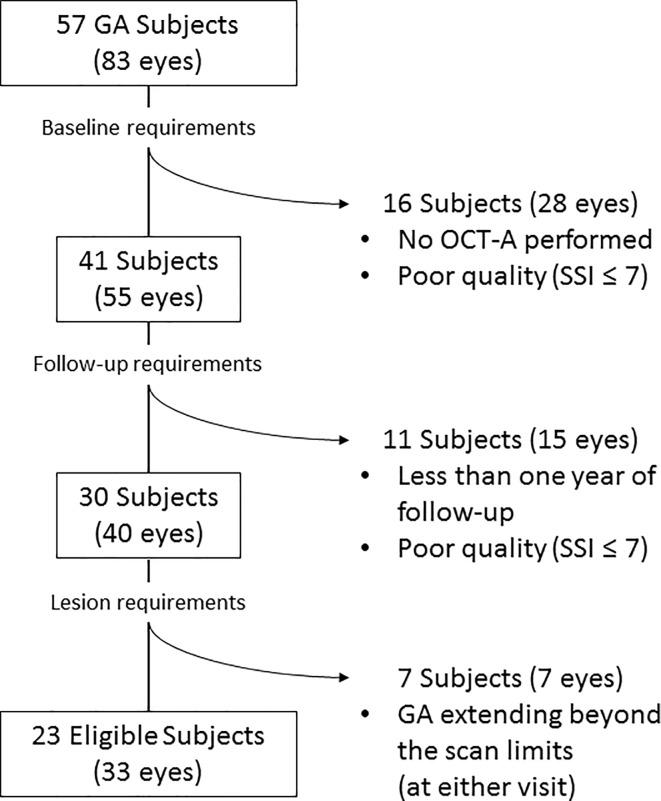
Flow chart diagram explaining the selection process of eligible eyes for the study.Among the initial cohort of 57 subjects with geographic atrophy (GA) in at least one eye, only 23 (33 eyes) met all the inclusion criteria and were included in the analysis. OCT-A: Optical coherence tomography angiography; SSI: Signal Strength Index.